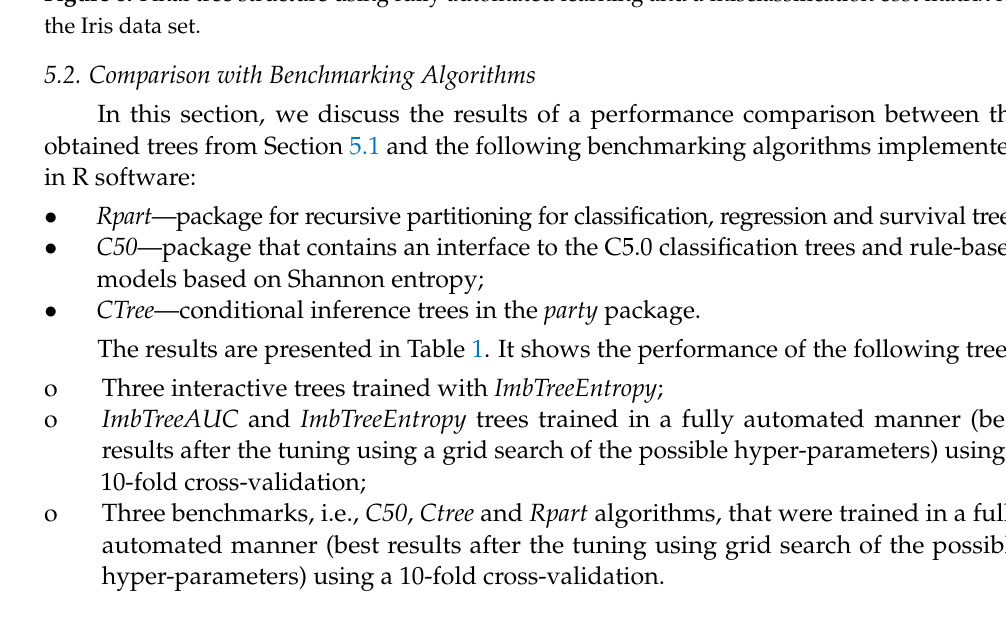
Table 1. Comparison between authors’ algorithms, including interactive learning, and other R packages for classification.